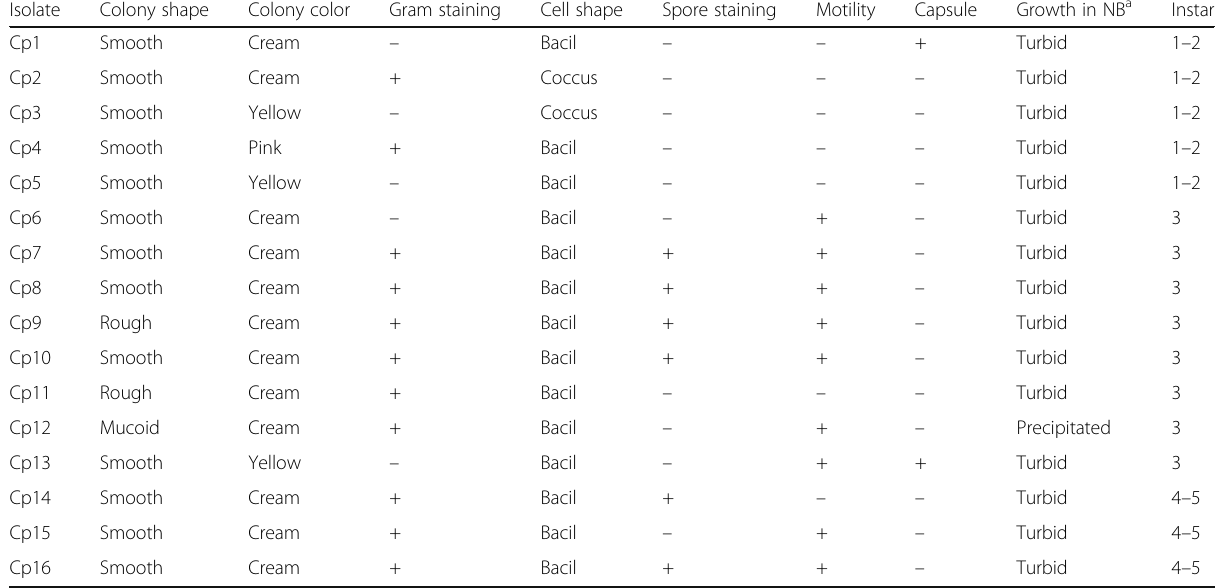
Table 1 The morphological properties of the bacterial isolates Isolate Colony shape